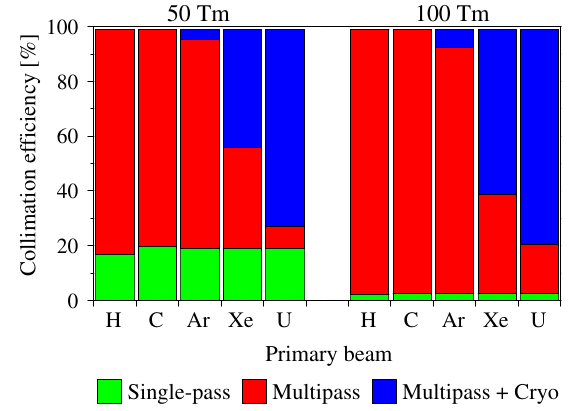
FIG. 11. Collimation efficiency of 1 H þ , 12 C 6 þ , 40 Ar 18 þ , 132 Xe 54 þ , and 238 U 92 þ primary beams at higher energies corresponding to the magnetic rigidities 50 and 100